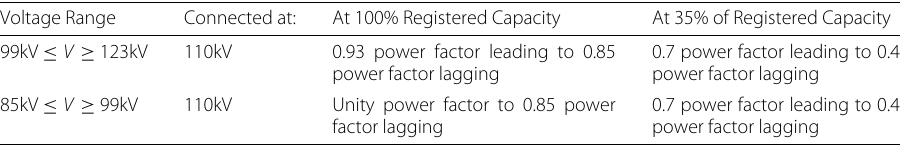
Table 1 Power Factor - Irish Distribution Code Example Voltage